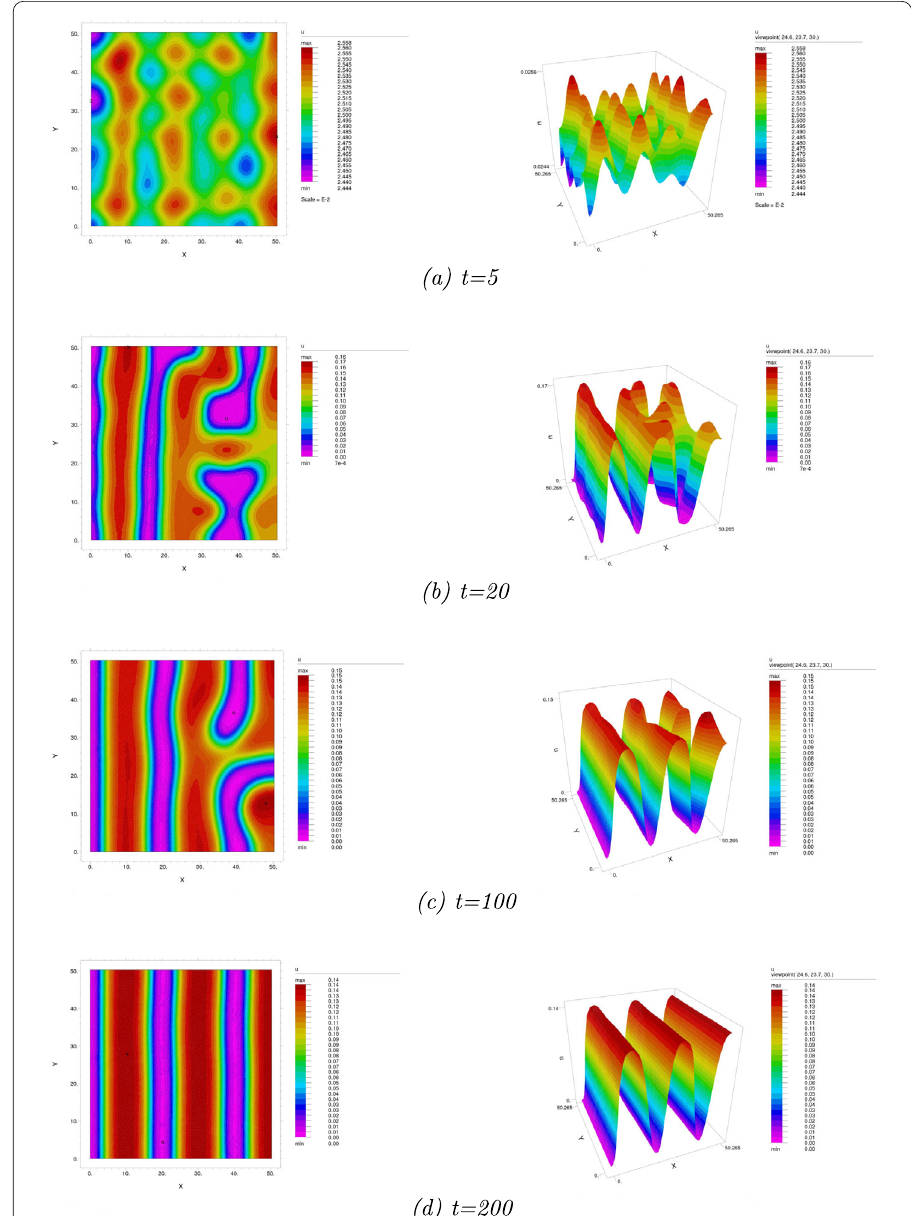
Figure 2 The process of Turing pattern for system (1.1) with parametersin (4.1), (4.2) and d = 1.3 > d 0 = 1.2066